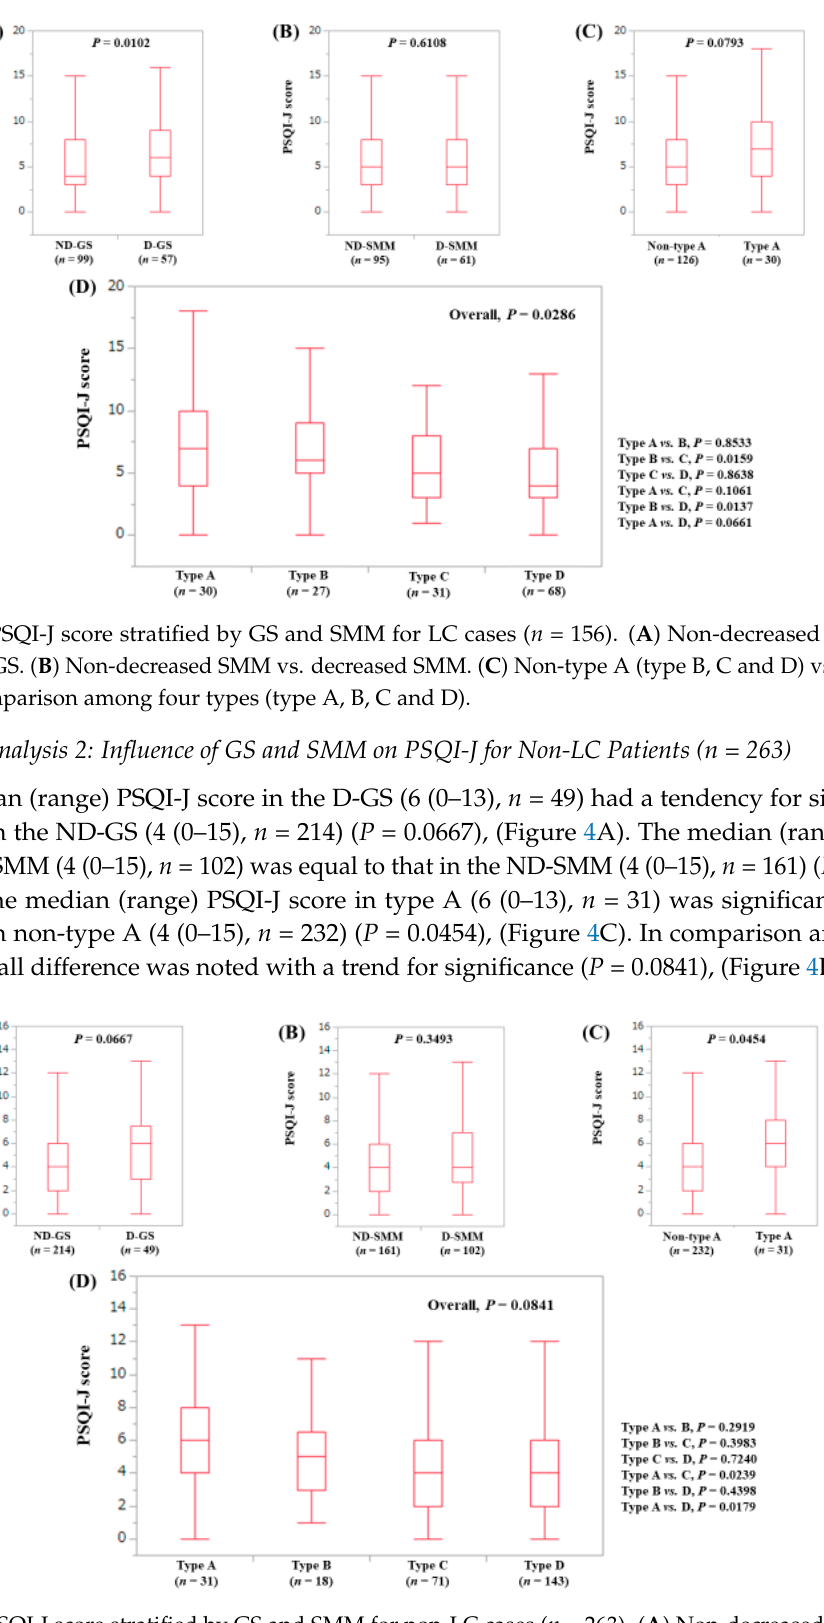
Figure 4. PSQI ‐ J score stratified by GS and SMM for non ‐ LC cases ( n = 263). ( A ) Non ‐ decreased GS vs. decreased GS. ( B ) Non ‐ decreased SMM vs. decreased SMM. ( C ) Non ‐ type A (type B, C and D) vs. A. ( D ) Comparison among four types (type A, B, C and type A. ( D ) Comparison among four types (type A, B, C and D).